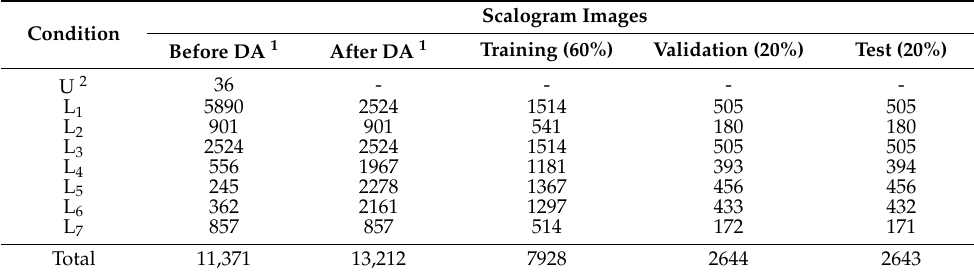
Table 2. Amount of scalogram images before and after data augmentation and their subdivision into datasets for training, validation, and test of the convolutional neural networks (12 computation times per day). 1 DA states for data augmentation. 2 U states for undefined